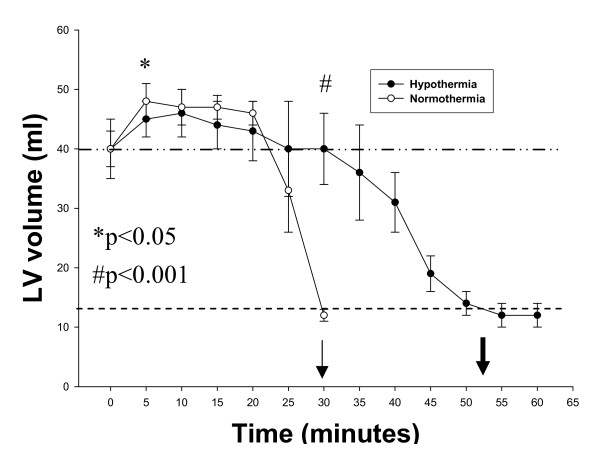
The time course of mean left ventricular (LV) volumes (mean ± SEM) during untreated VF in both normothermia and hypothermia swine. *Ventricular volume differs between the two groups with less dilation of hypothermia group (p < 0.05). #Ventricular volume differs between the two groups with less contracture in the hypothermia group (p < 0.001). The dashed and dotted line represents baseline LV volumes at VF onset. The even dashed line represents LV volume at stone heart. The thin arrow represents time to stone heart in normothermia group. The thick arrow represents time to stone heart in hypothermia group.